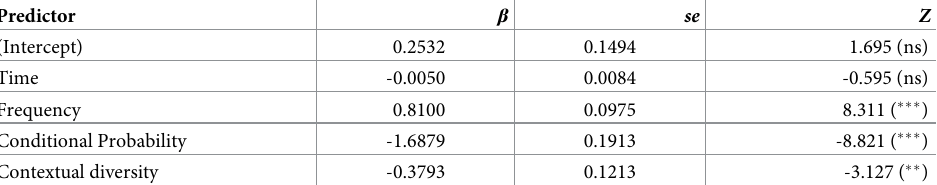
Outcome of the logistic mixed-effect model fitted considering all significant predictor s at once on categorization outcomes obtained using numeric overlap as the distance metric to retrieve nearest neighbors. Significance